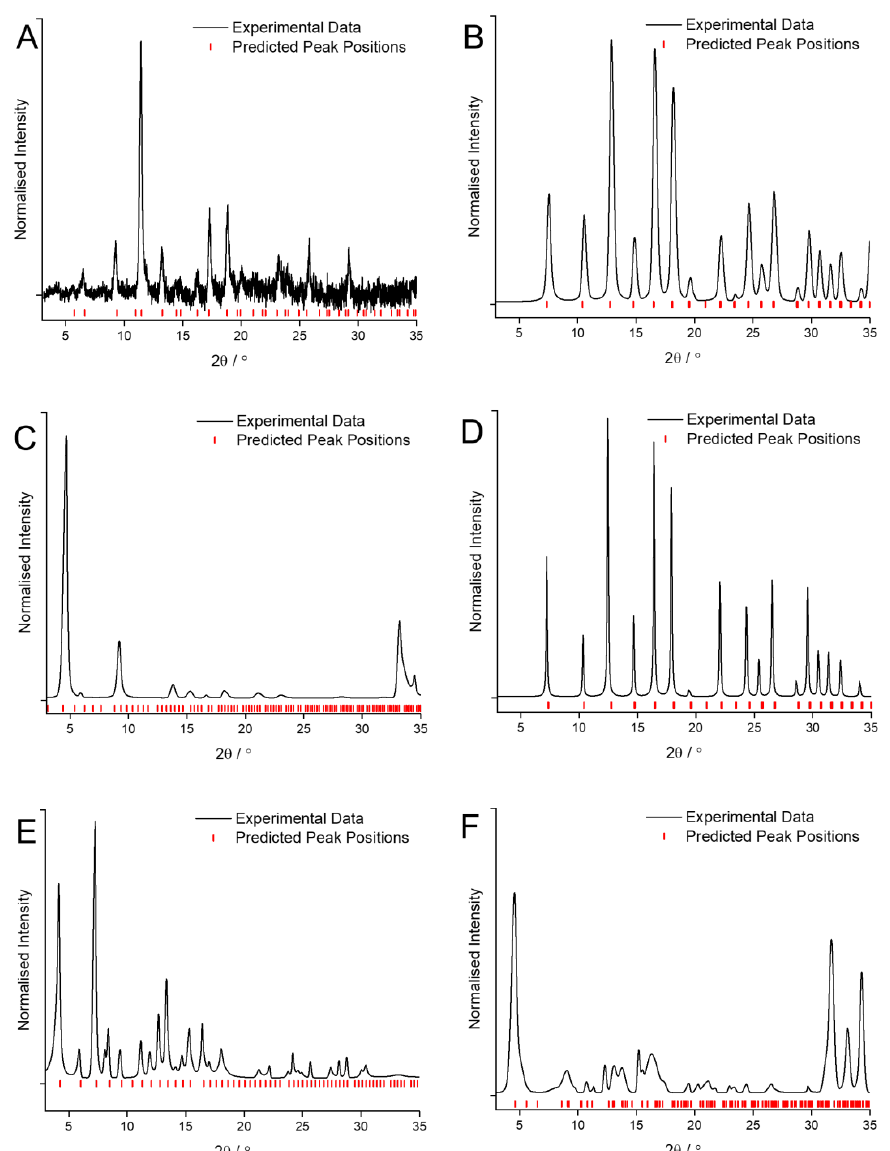
Figure 3. XRD patterns of the MOF coatings obtained using GVL as the solvent for: ( A ) Cu and BTC; ( B ) Zn and mIM; ( C ) Zn and bIM; ( D ) Co and mIM; ( E ) Zn and eIM; ( F ) Zn and IM compared against predicted peak position values [27,28,31 – 33].